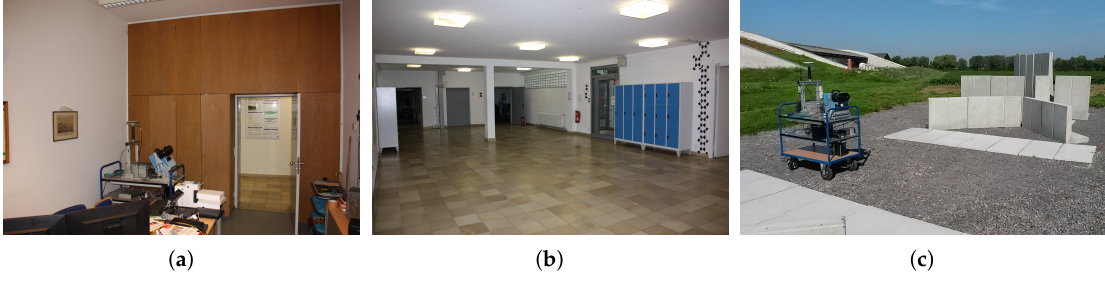
Figure 5. ( a ) Office room, ( b ) hallway and ( c ) concrete blocks in an outdoor environment, scanned with scan rates of 254 kHz and 508